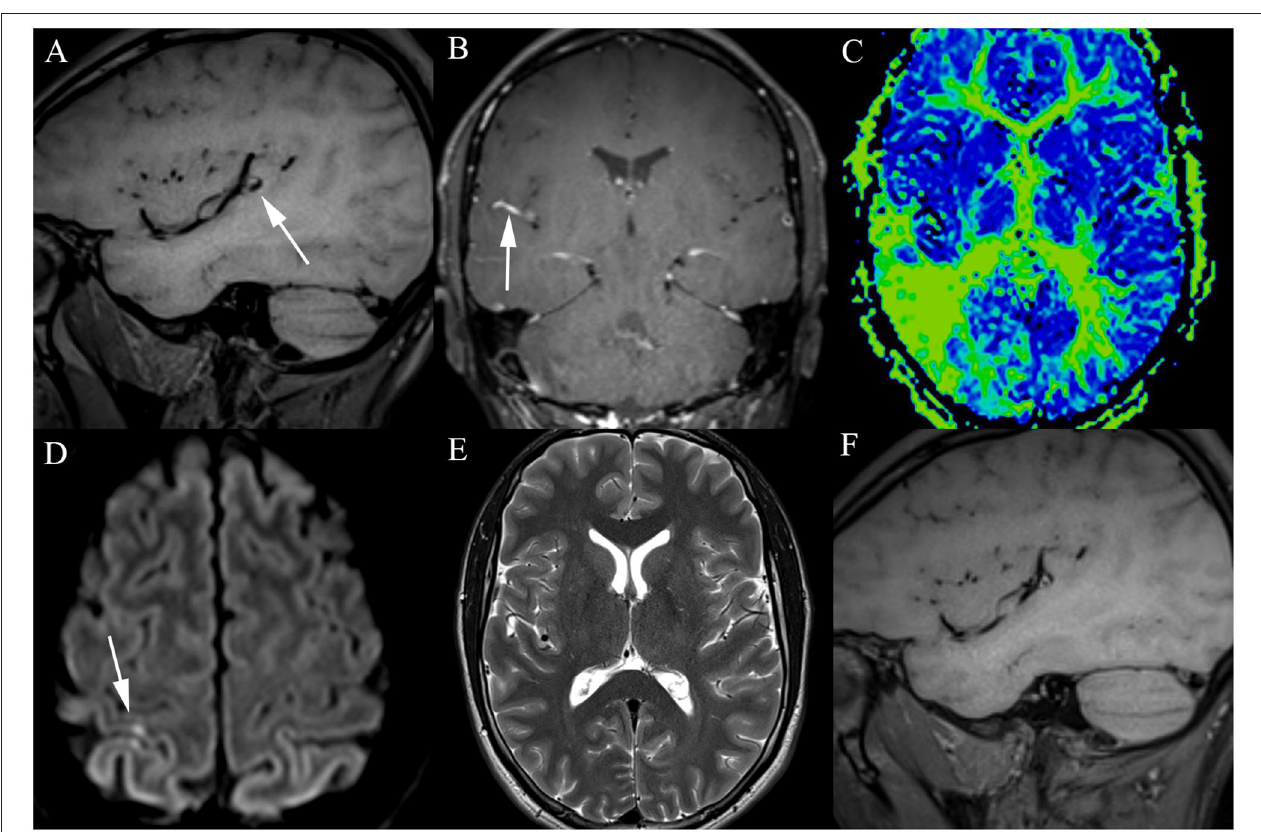
FIGURE 3 | Postinterventional imaging findings: (A) T1-weighted image 6 months after flow diverter implantation showing hyperintense thrombotic material around the flow diverter and near-complete occlusion of the aneurysm. The initial severe stasis at the dome ( Figure 2B ) is depicted as a hypointense cap. (B) Slow flow in the side branch originating from the aneurysm wall is documented 6 months post intervention after changing to monotherapy with aspirin. (C) Perfusion deficit of the affected territory is visible on mean transit time reconstructions of the MRI perfusion. (D) Small ischemic lesions, located in the right superior parietal lobule, are seen on DWI. (E) One month after detection of the slow flow in the side branch of the aneurysm-wall, T2-weighted images did not reveal an infarction in areas with delayed perfusion. (F) As 12 month-follow-up MRIs reveal, the aneurysm is completely filled with a hyperintense thrombotic material, which means that full occlusion of the aneurysm was